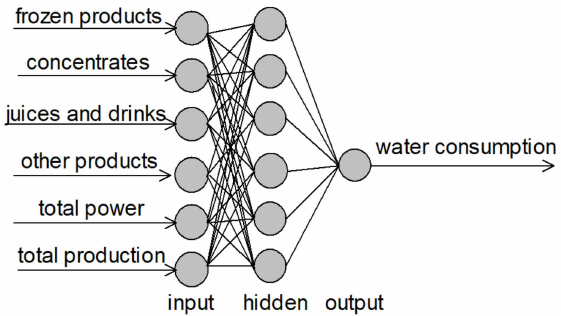
Figure 2. Schematic neural network architecture.